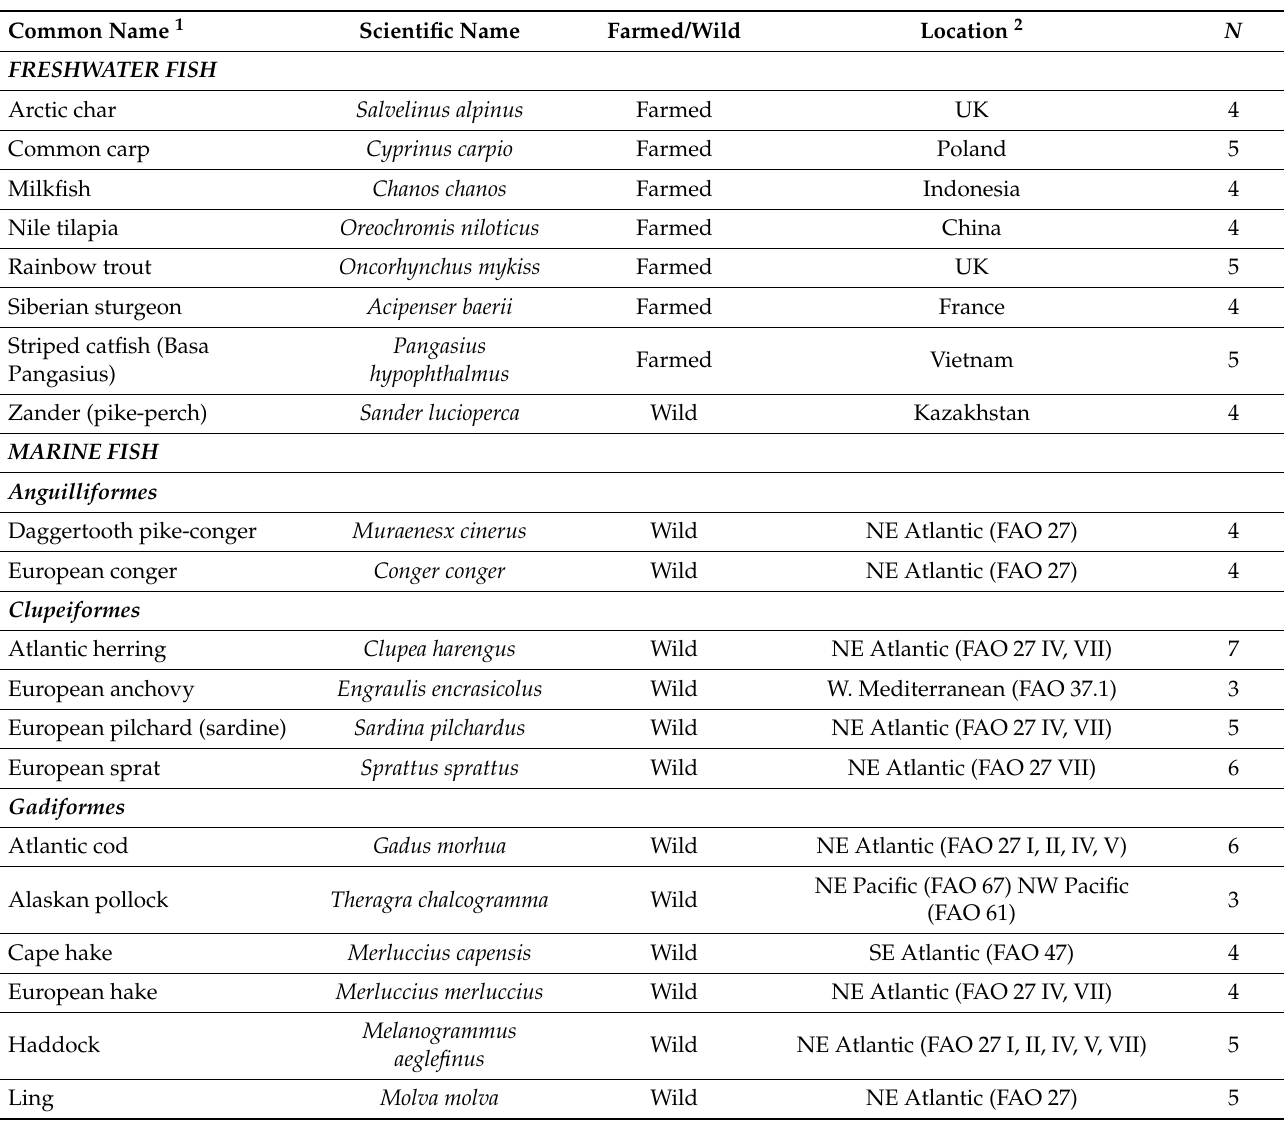
Table 1. List of the 95 seafood samples analysed for iodine content in the current study. All samples raw unless indicated by